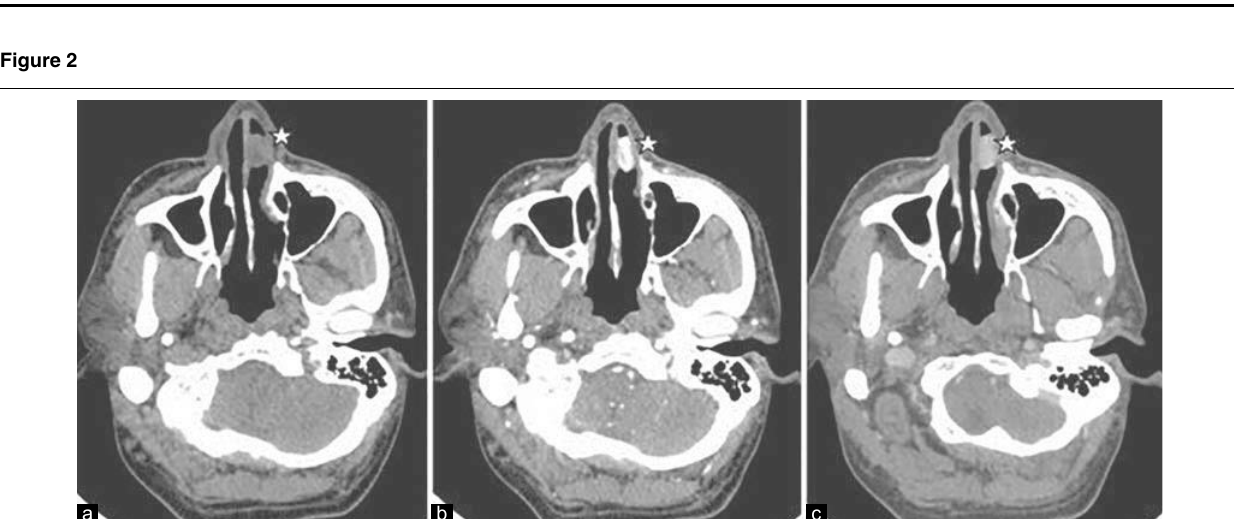
lacrimoauriculodentodigital syndrome, characterized by hypoplasia, aplasia, or atresia of the lacrimal system, deafness and ear malformations, and dental and digital anomalies [8]. Th ere were no such anomalies present in our patient. Th e lack of salivary gland related symptoms was probably because of the secretions of the other salivary glands compensating for this. Salivary gland aplasia can be diagnosed with a variety of imaging techniques that include ultrasonography, CT, MRI sialography or scintigraphy. In our patient we were able to confi rm the diagnosis with the help of a CT scan. Th e characteristic imaging feature in CT is the nonvisualization of the submandibular gland, which is often replaced by fatty tissue, the margins of which are well defi ned with no signs of invasion of the adjacent soft tissue or bone and compensatory hypertrophy of the contralateral submandibular gland, as seen in our case.